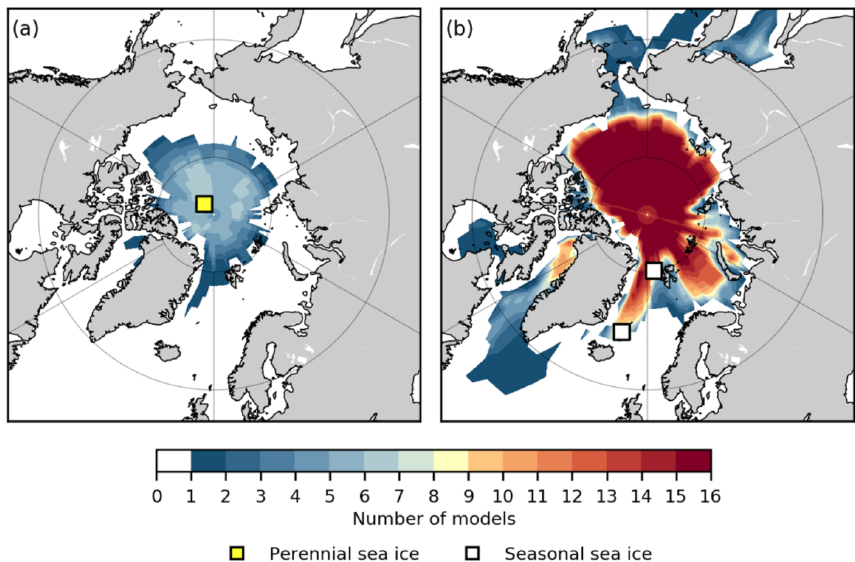
Figure 10. Number of models simulating (a) annual mean perennial sea ice (sea ice concentration of ≥ 0 . 15) at any given location in the Arctic in the mPWP simulations and (b) monthly mean sea ice in any month of the year. Depicted squares represent the locations of the reconstructions and their respective colour the inferred mPWP sea ice conditions at that location.